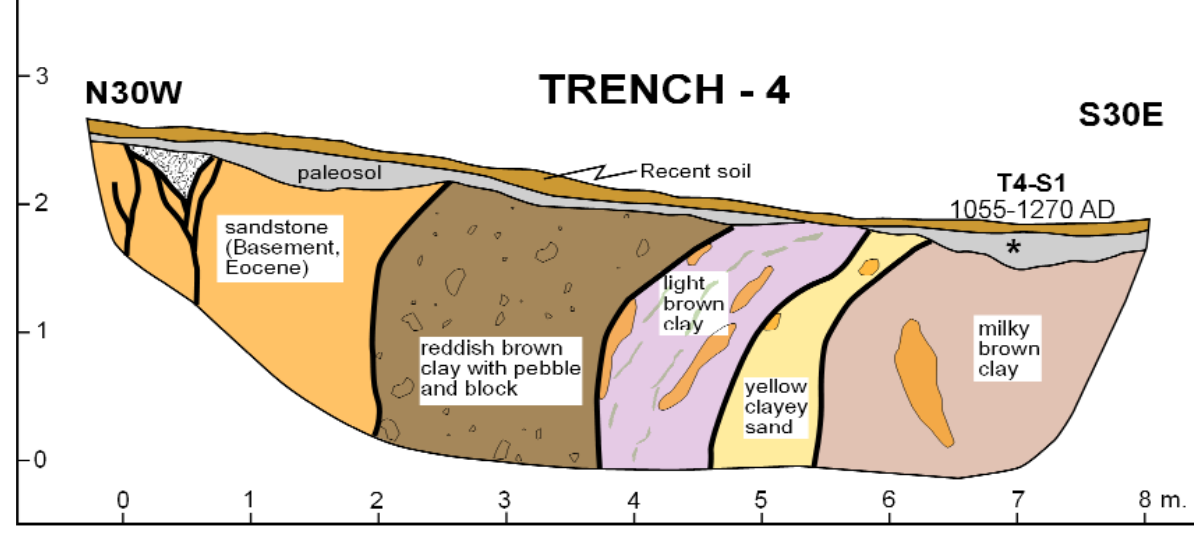
Figure 12. Log of Trench-4, eastern